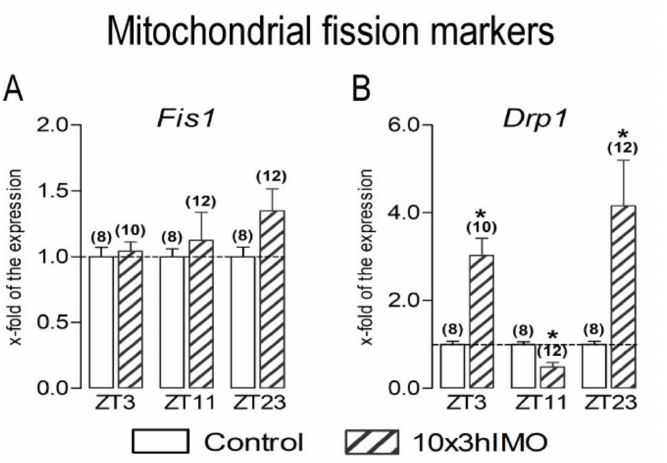
Figure 5. Different transcriptional profiles of mitochondrial fission markers in spermatozoa of repeatedly stressed adult rats at different time points. Spermatozoa isolated from undisturbed and repeatedly stressed rats were used for RNA isolation and further analysis of the transcriptional profile of markers of mitochondrial fission. Data bars are mean ± SEM values of two independent in vivo experiments (n = number of rats). Statistical significance was set at level p < 0.05: * vs. control group of the same time